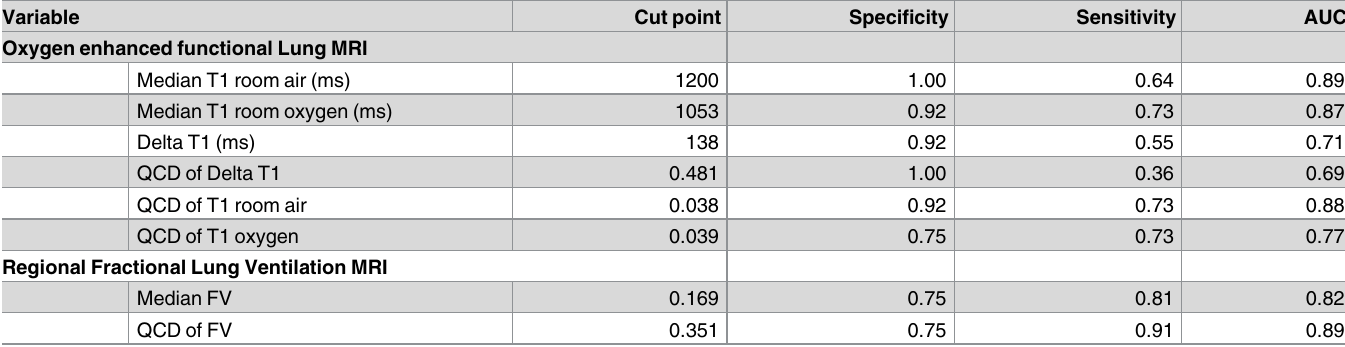
Table 3. Receiveroperating characteristics analysis.